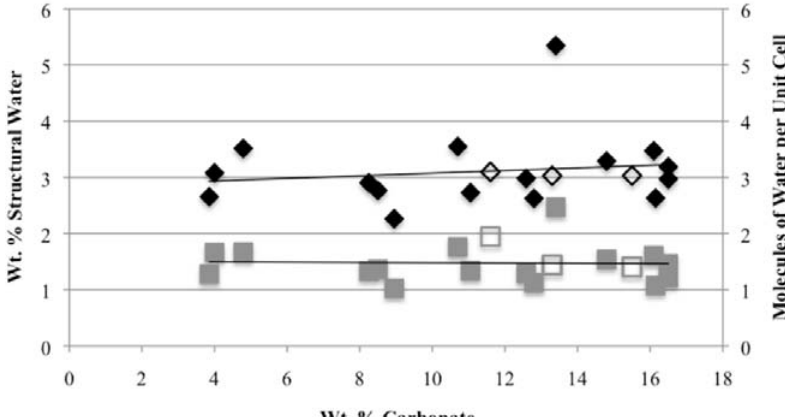
Figure 1. Weight percent structural water and molecules of water per unit cell as a function of weight percent carbonate in 20 carbonated hydroxylapatite samples synthesized with two hour digestion periods at 60 °C. Black diamonds indicate weight percent structural water and gray squares indicate molecules of water per unit cell. Hollow markers indicate a synthesis and digestion at 80